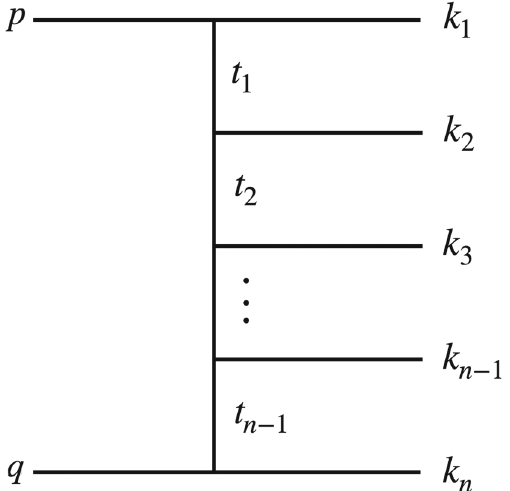
Fig. 3 Feynman diagram used to fix the convention in the